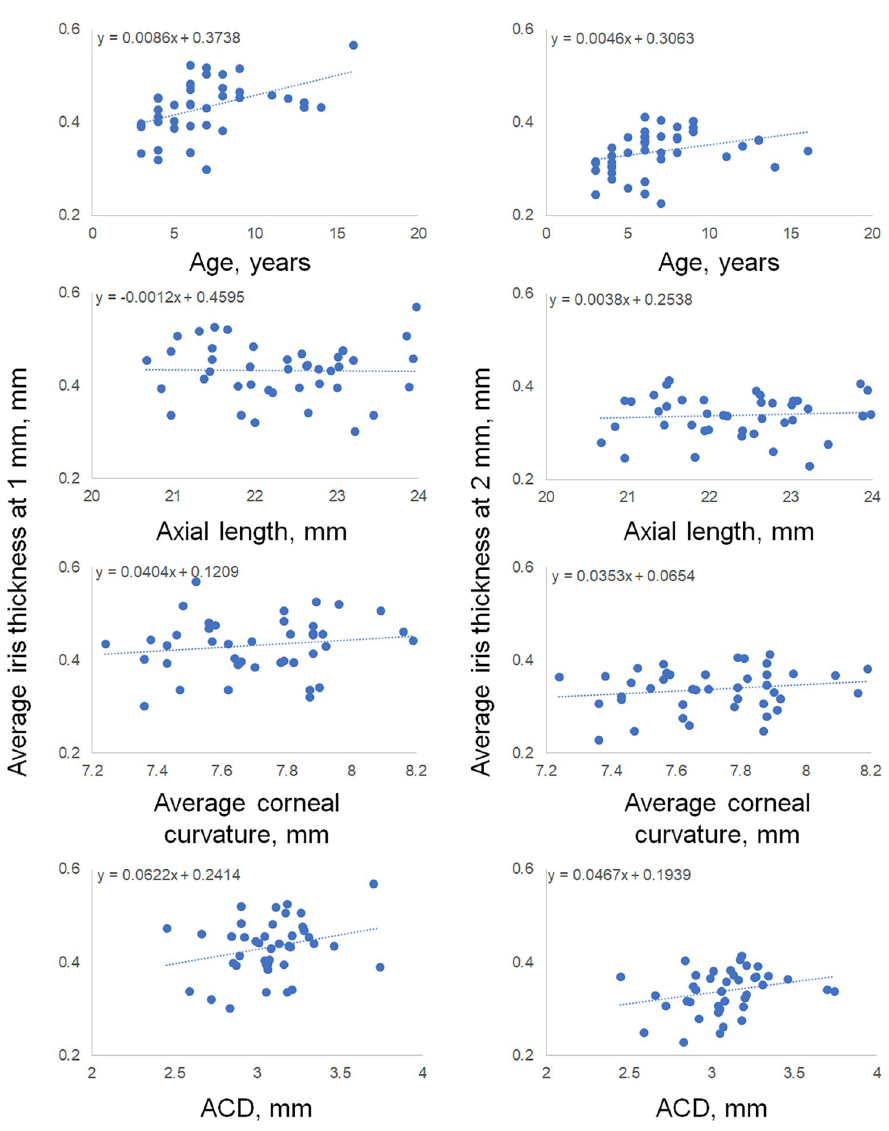
Fig 2. Association between the average IT and age, axial length, average corneal curvature, and ACD. Pearson’s correlation coefficient (r) between the average IT (temporal and nasal) and age was 0.45 and 0.31 at 1 and 2 mm, respectively (Fig 2 upper). The coefficient (r) between the average IT and axial length was − 0.01 and 0.07, respectively (Fig 2 second line). The coefficient (r) between the average IT and average corneal curvature was 0.15 and 0.17, respectively (Fig 2 third line). The coefficient (r) between the average IT and ACD was 0.26 and 0.26, respectively (Fig 2